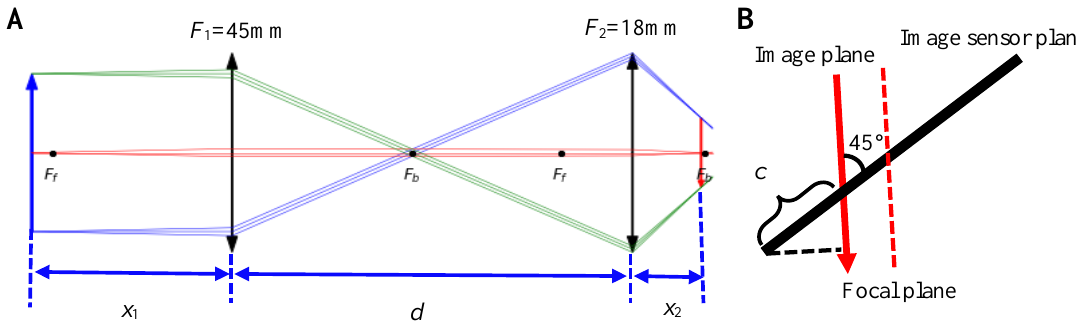
Figure 4. Modeling parameters of optical imaging system. ( A ) The optical system consisting of two objective lenses with an effective focal length (EFL) of 45 mm and 18 mm, respectively. The distance from specimen plane to objective lens I is represented by x 1 , and the two objective lenses are separated by a distance of d . The distance from objective lens II to the image plane is represented by x 2 . ( B ) The geometric relationship between image plane and image sensor plane.